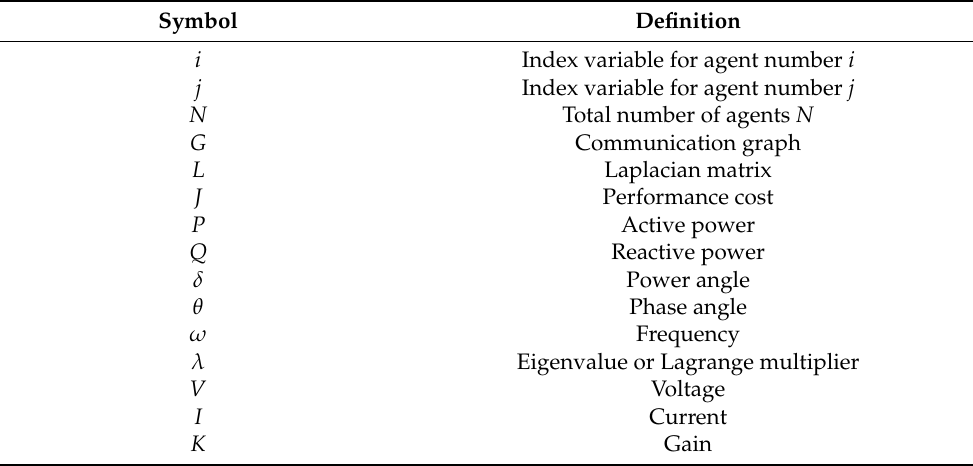
Table 1. Nomenclature.